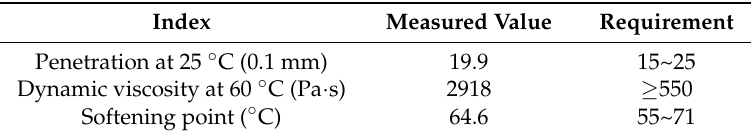
Table 2. Basic properties of 20# matrix asphalt.